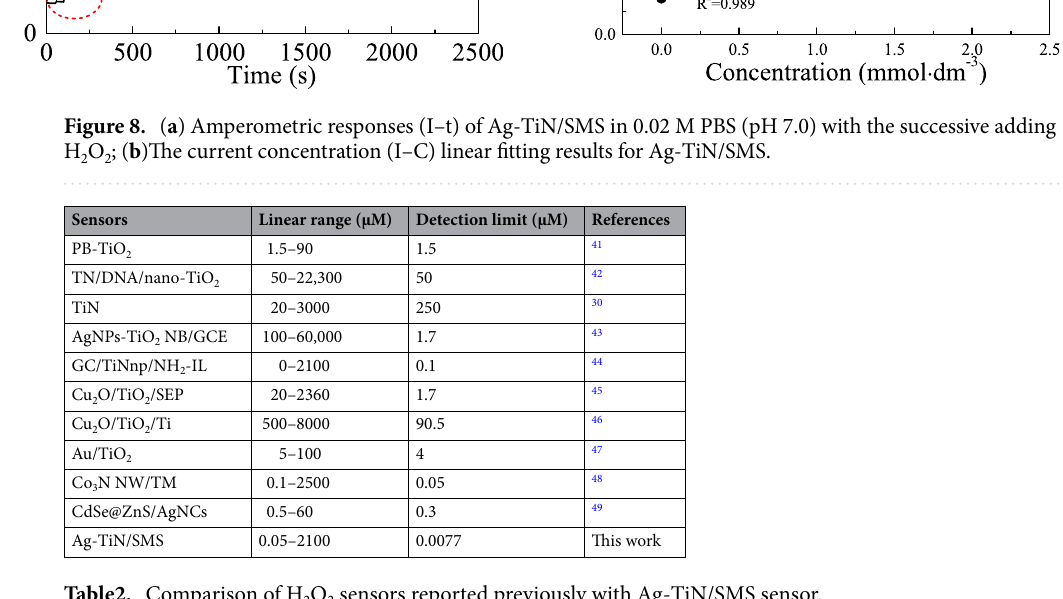
Table2. Comparison of H 2 O 2 sensors reported previously with Ag-TiN/SMS